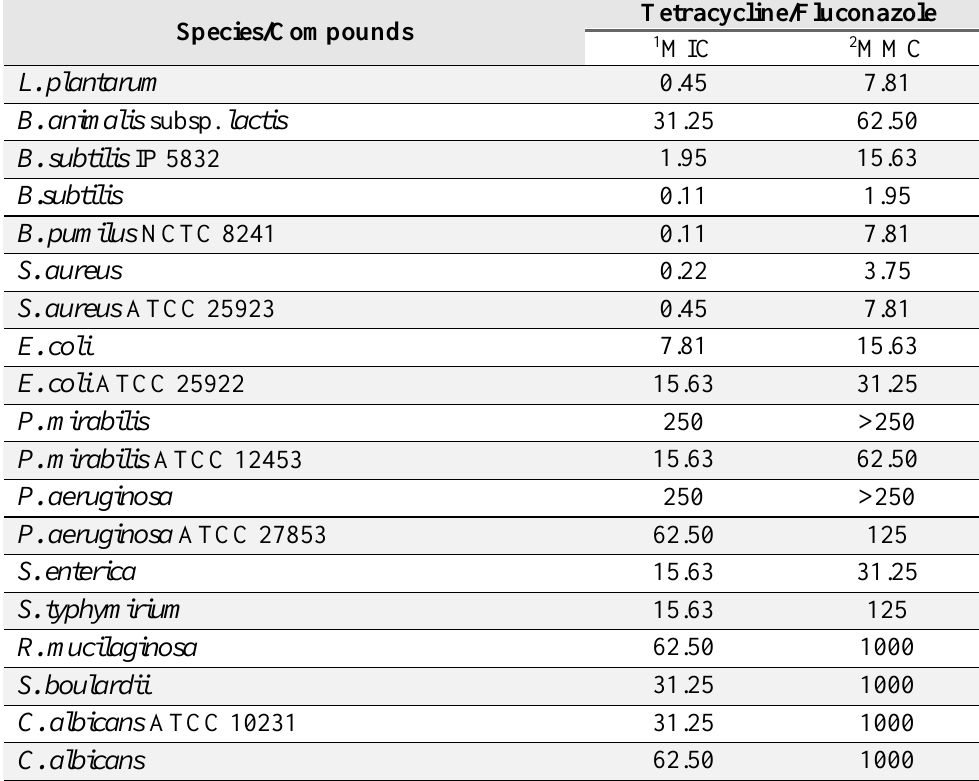
Table 6. Antimicrobial activity of positive control (tetracycline and